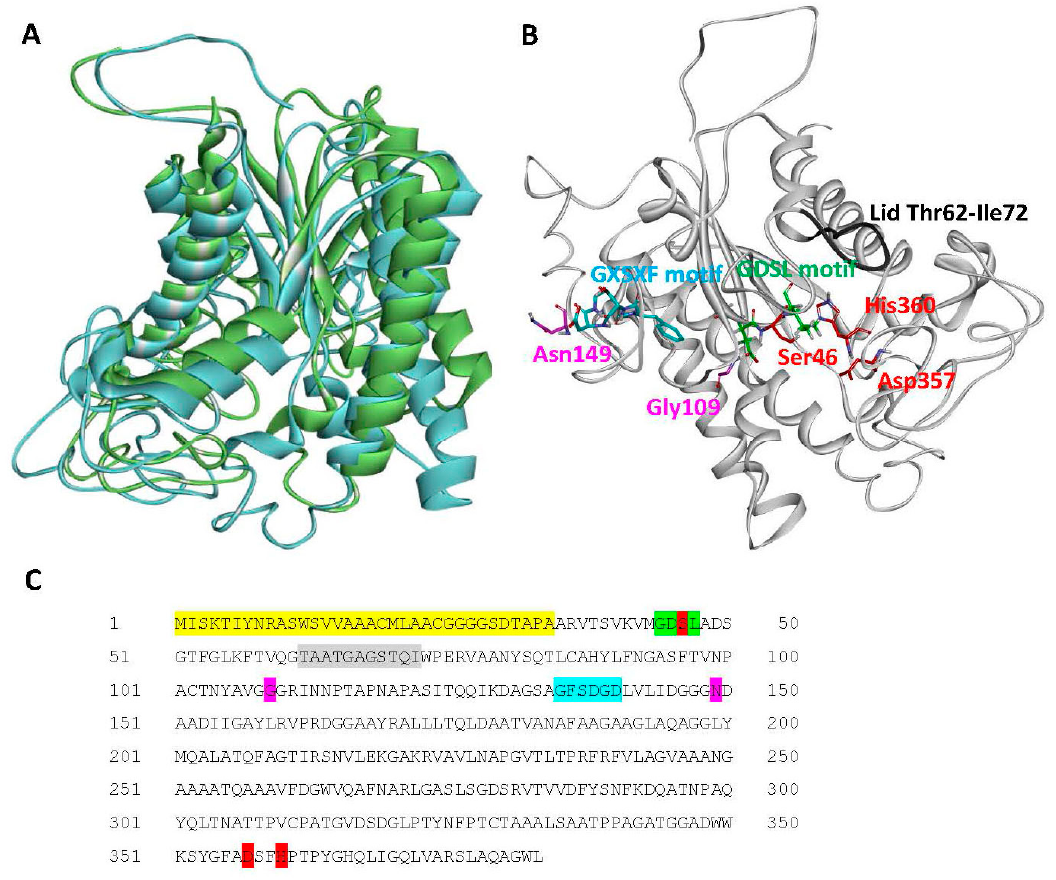
Figure 3. Structural analysis of A . citrulli M6 Lip1. ( A ) Structural alignment between Lip1 (blue ribbon), and the passenger domain of the autotransporter EstA from Pseudomonas aeruginosa (green ribbon; PDB code 3KVN). ( B ) Predicted structural model of Lip1 generated by I-TASSER, and ( C ) Lip1 sequence. Conserved residues and motifs are highlighted and shown in sticks as follows: red, catalytic triad; green (and red for Ser46), GDSL motif; blue, GXSXG motif; purple, oxyanion hole residues; and grey, putative lid loop (ribbon only). The secretion signal peptide as predicted by Pred-Tat and Phobius is highlighted yellow in the protein